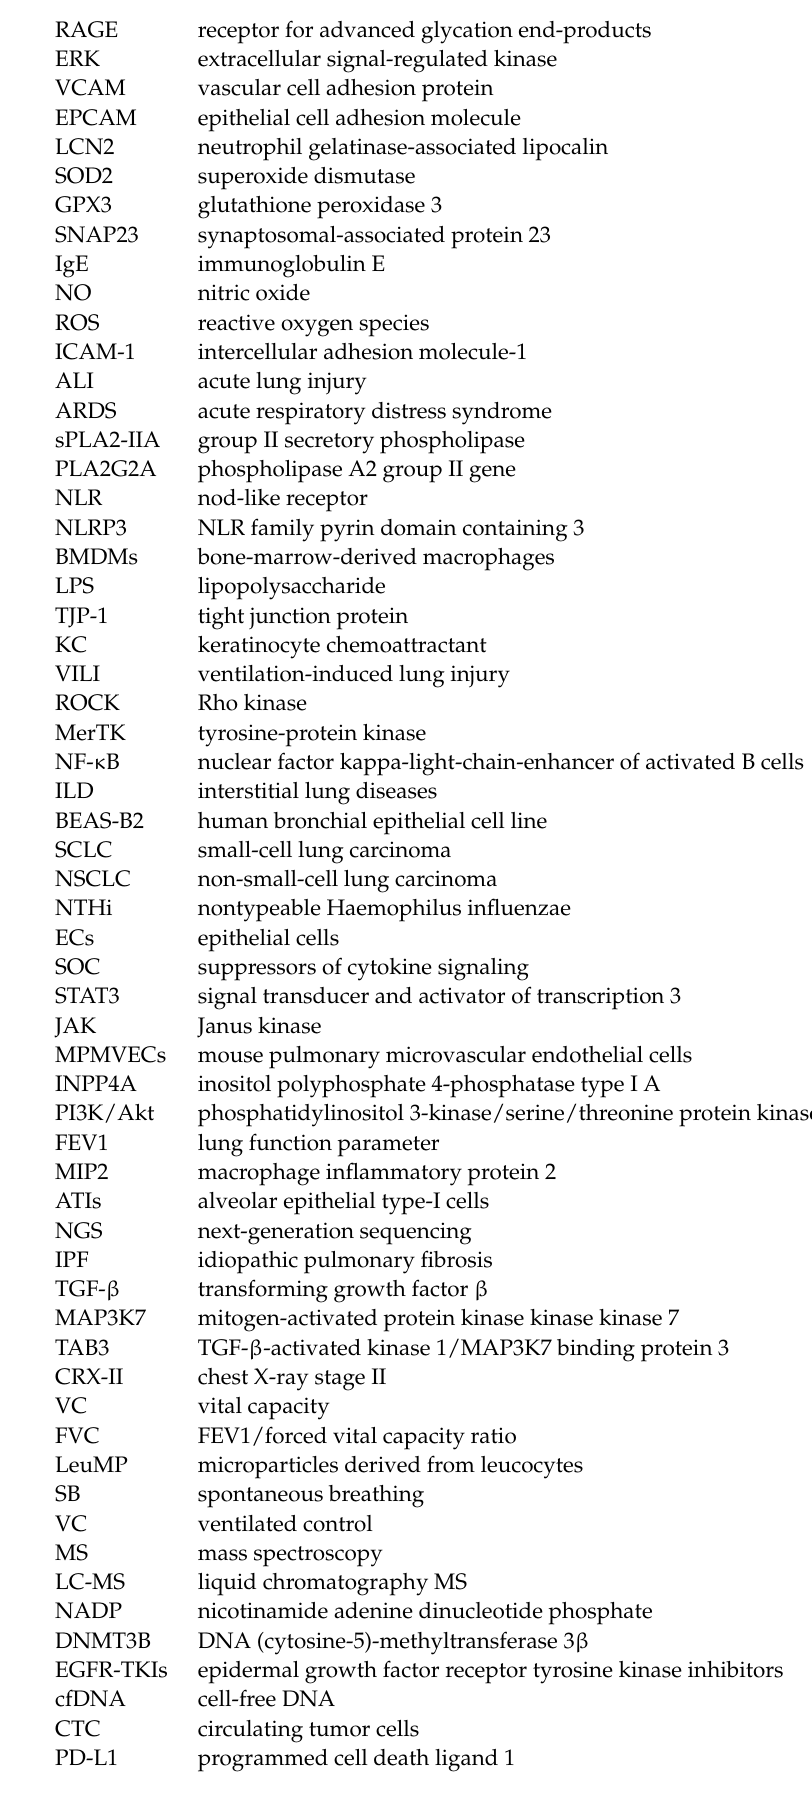
TGF- β -activated kinase 1/MAP3K7 binding protein